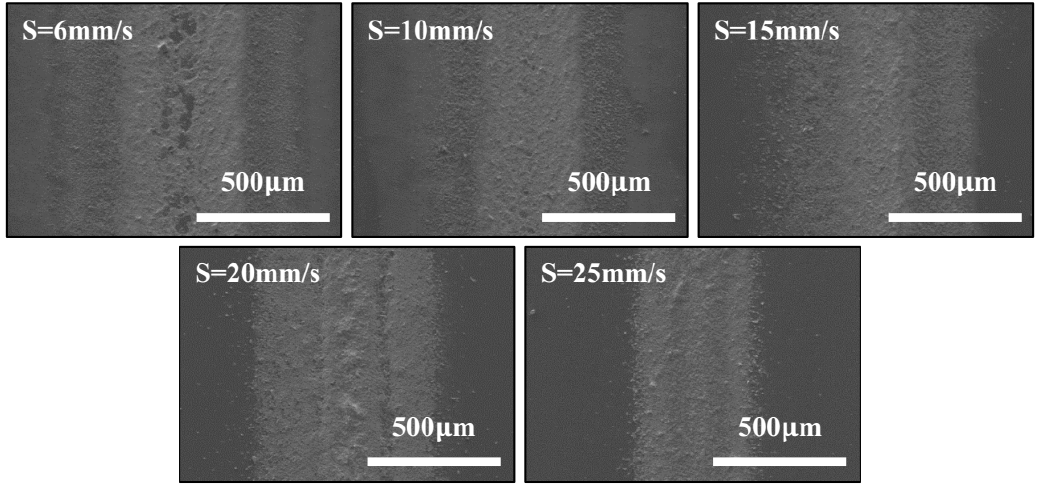
Figure 4. Photographs of linear glass frit film at different motion speeds ( S ) of the substrate (6, 10, 15, 20, and 25 mm/s).